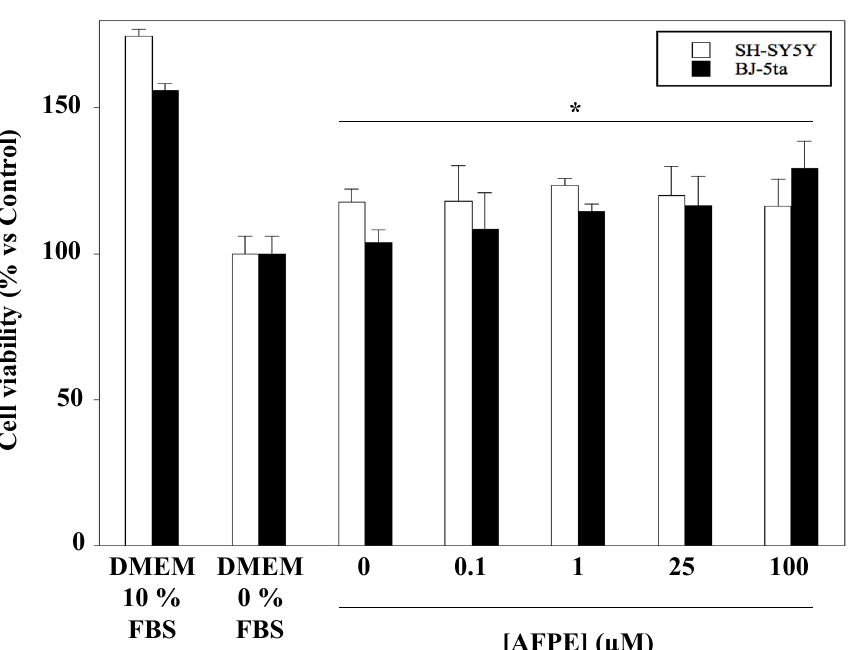
Figure 3. Effect of AFPE exposure on viability of SH-SY5Y and BJ-5ta cells. Cells kept in serum-free DMEM were treated with the indicated increasing amounts of AFPE in serum-free conditions for 24 h, and then subjected to an MTT assay. For each treatment, data are presented as mean ± SD ( n = 3) of the control cells, cultured in serum-free DMEM, set as 100%. NB. 100 µ M AFPE in the reaction mixture corresponds to 23 mg of apple flesh/mL. * Not significant vs. control cells ( p values of 0.3345 and 0.1617 for SH-SY5Y and BJ-5ta cells, respectively).